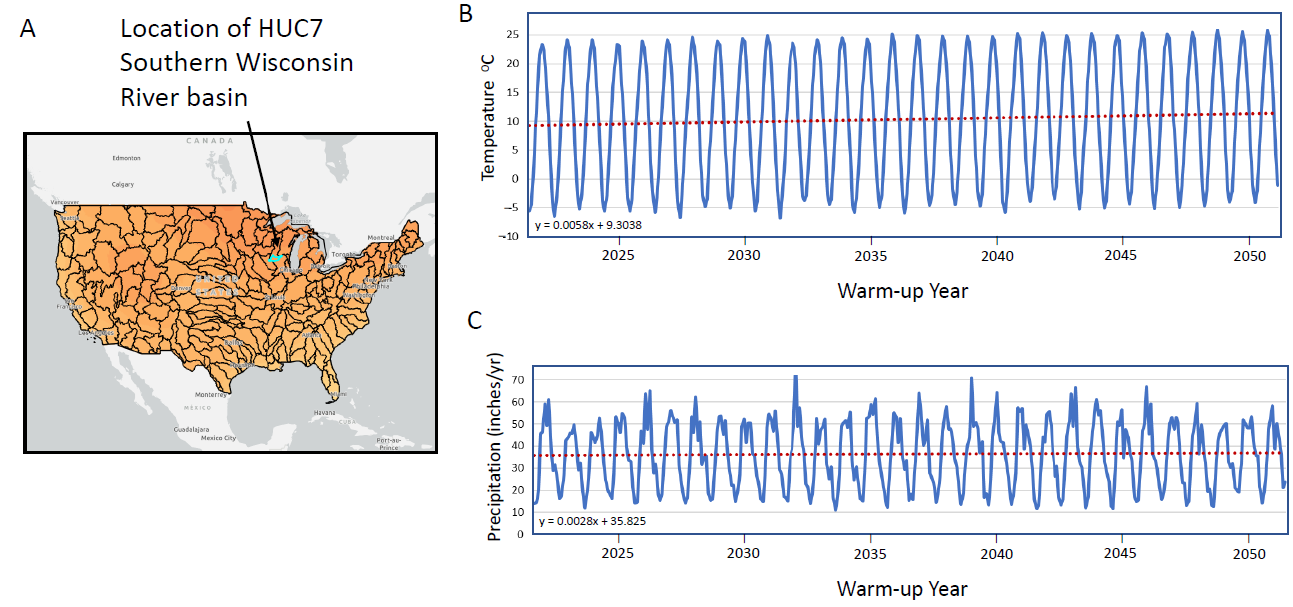
Figure 2. Climate forcing used in the synthetic model from high-emissions RCP8.5 scenario [16] downscaled to southern Wisconsin. ( A ) Location of southern Wisconsin basin [29] to which [16] data correspond, ( B ) the atmospheric temperature used to set the temperature of the infiltration (°C), and ( C ) precipitation and infiltration rate forcing (inch/year) where infiltration through the root zone is assumed to be one quarter the precipitation. Equations on plots correspond to dashed linear trend lines. RCP stands for Representative Concentration Pathway.